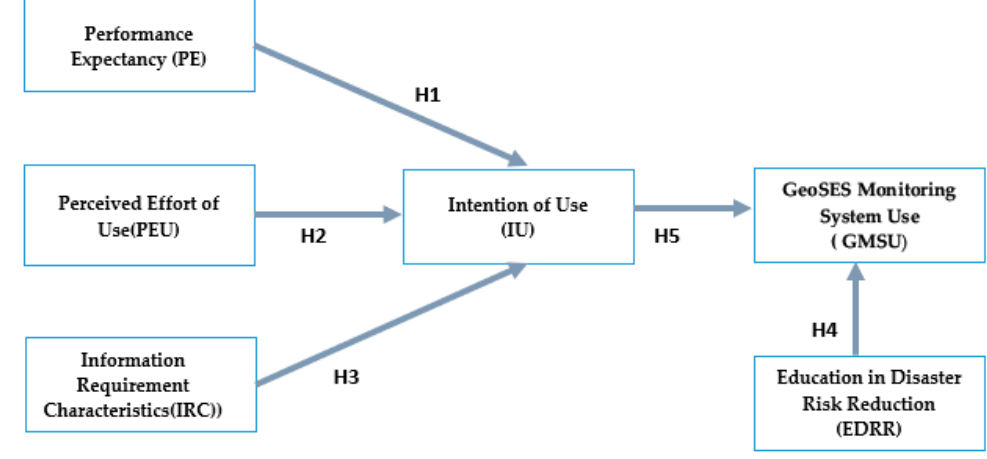
Figure 5. Proposed model. Source: authors.